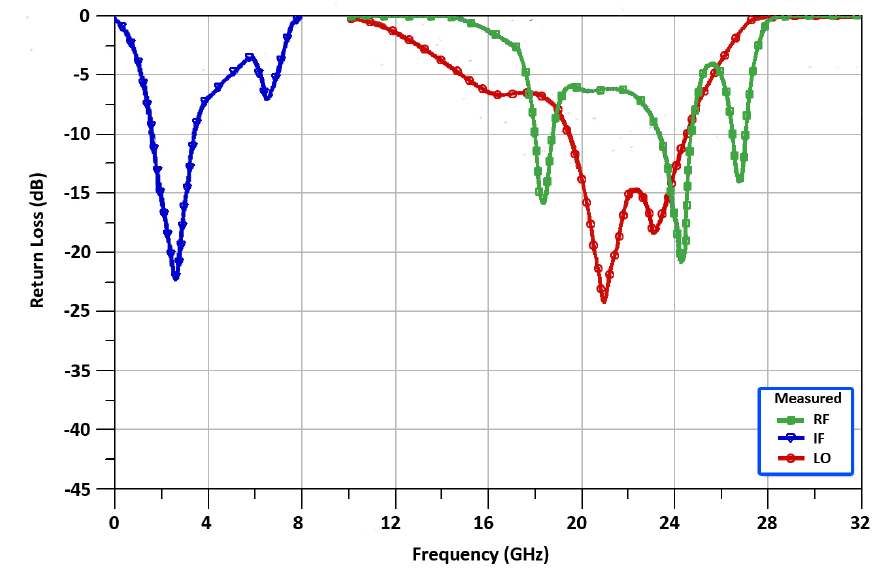
Figure 11. The Mixer’s measured return loss.